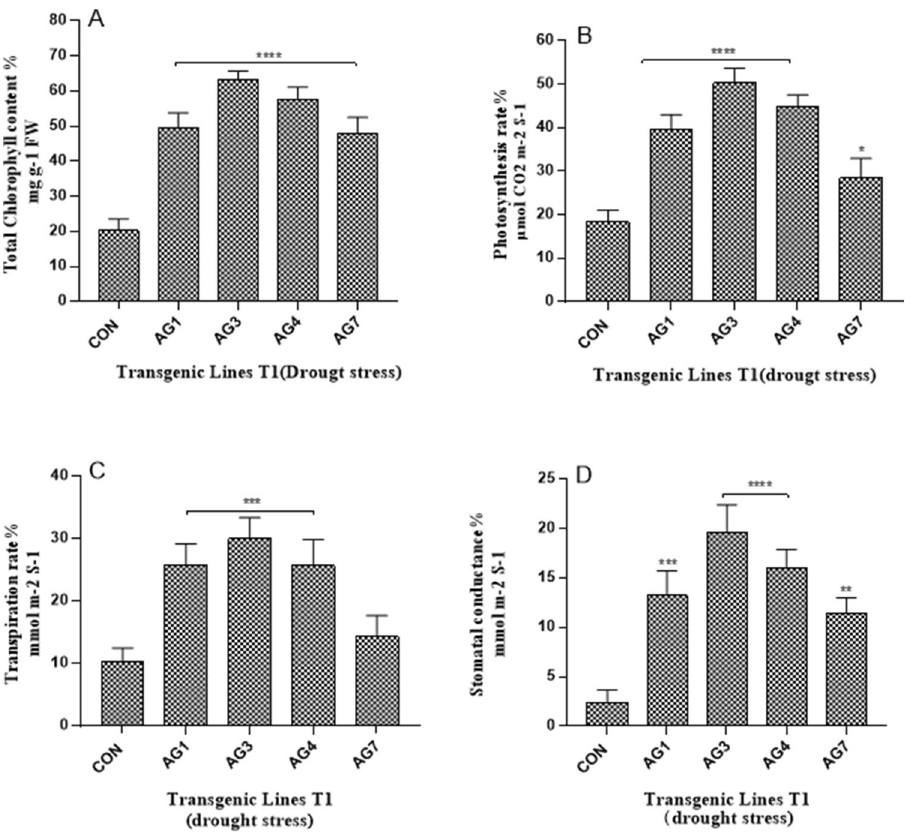
Figure 7. Percentage estimation before and after drought stress in leaves of control and transgenic lines. ( A ) Total chlorophyll contents %; ( B ) Photosynthetic rate %; ( C ) Transpiration rate %; ( D ) Stomatal conductance %. Each bar depicts the average of biological triplicates from control and transgenic lines. Asterisks specify significant variation: “**** P value ≤ 0.0001; *** P ≤ 0.001; ** P value ≤ 0.01 * P value ≤